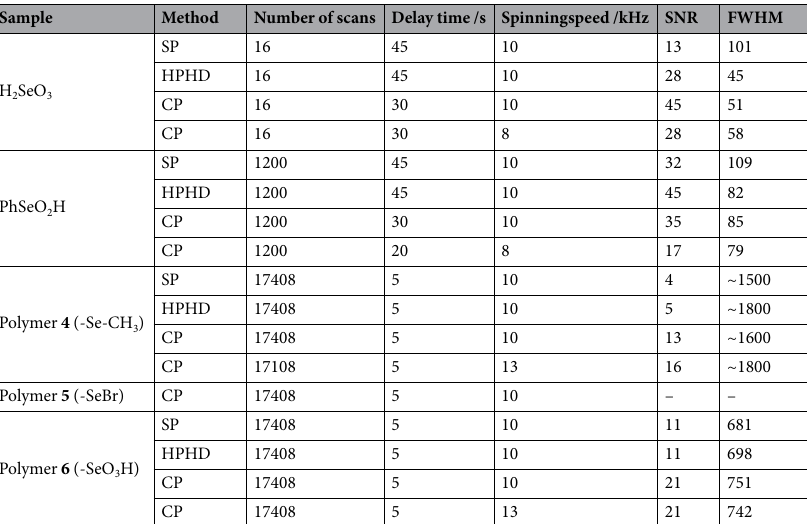
Table 1. Experimental parameters and chemical shift for different